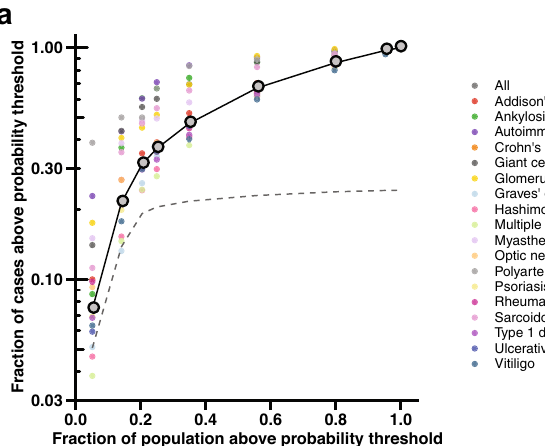
Fig. 3 | Model performance in capturing diverse autoimmune conditions. a Fraction of cases diagnosed with one of 18 autoimmune conditions above a probability threshold on a base-10 logarithmic scale versus the fraction of indivi- dualsthataretestedforautoantibodiesattheequivalentprobabilitythreshold.The dashed line marks the fraction of tested individuals above each probability threshold. The gray point indicates the mean across all autoimmune conditions. The columns of points represent values at different probability thresholds